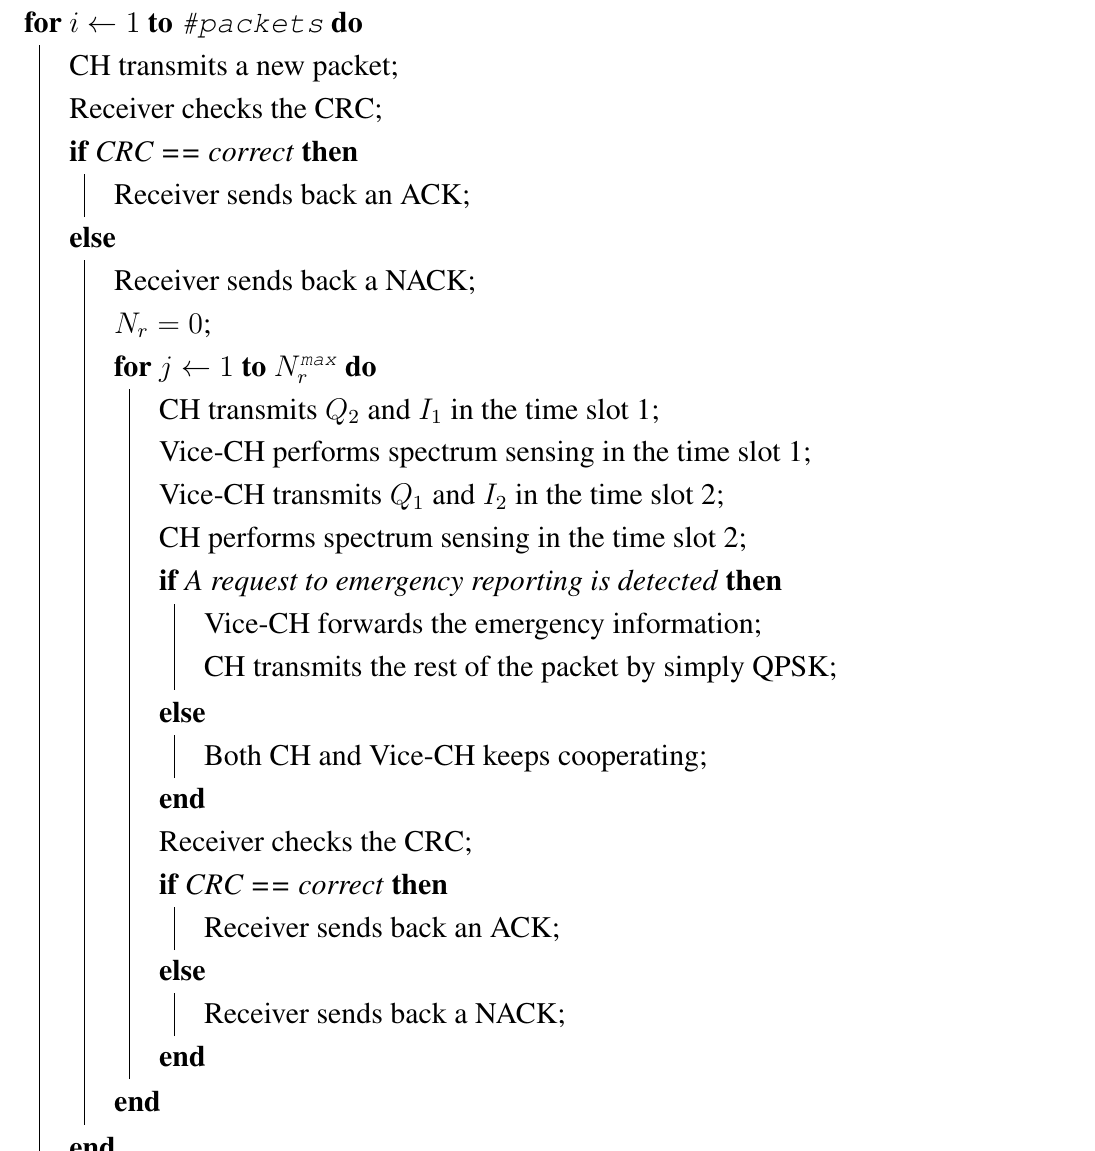
Algorithm 3: Communication between the clusters. The cooperative modulation diversity with spectrum sensing is invoked if errors